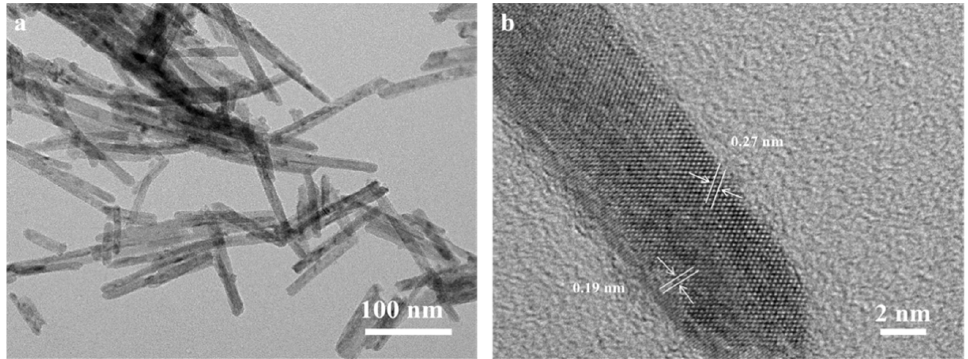
Figure 2. TEM ( a ), HR-TEM ( b ) images of CeO 2